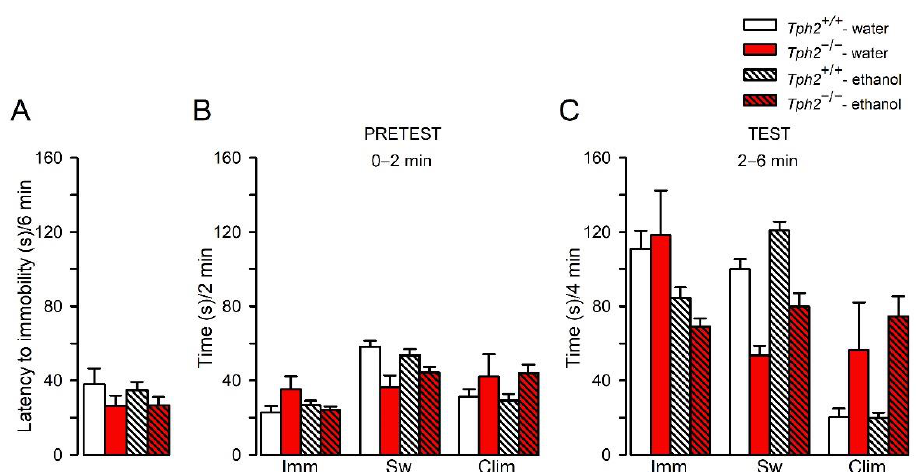
Figure 2. Effects of ethanol consumption in Tph2 −/− mice on the behavior in the FST. Following 29 days of exposure to the increasing concentrations of ethanol, the animals were individually placed in a beaker filled with water, and the following parameters were measured in 2-min intervals for 6 min: ( A ) latency to immobility, and immobility (Imm), swimming (Sw), and climbing (Clim) during